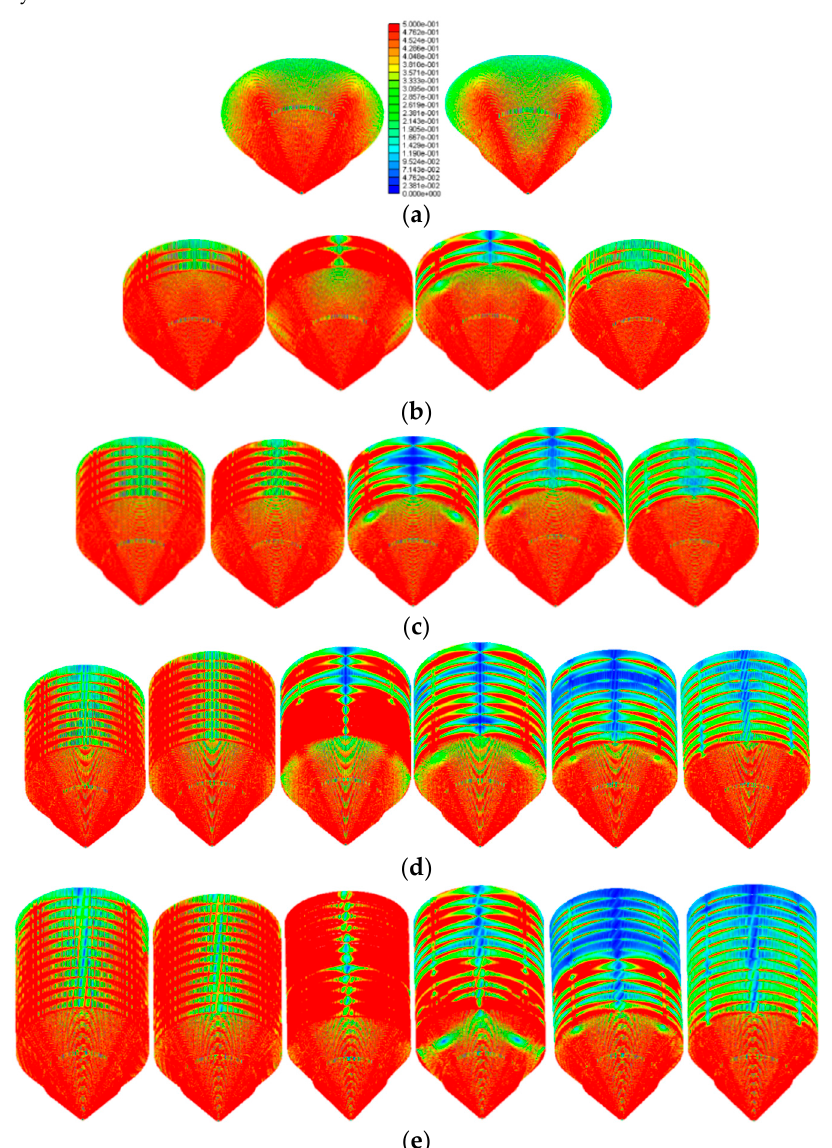
Figure 17. The surface current distributions on the upper cones of the ( a ) base, ( b ) 6-ring, ( c ) 12-ring, ( d ) 18-ring, and ( e ) 24-ring-loaded MBAs at the middle frequency from band 1 to band 6 in Table 1.